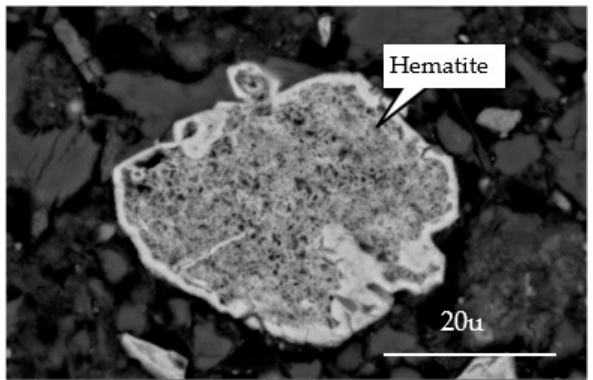
Figure 10. The microstructure of hematite in calcine.